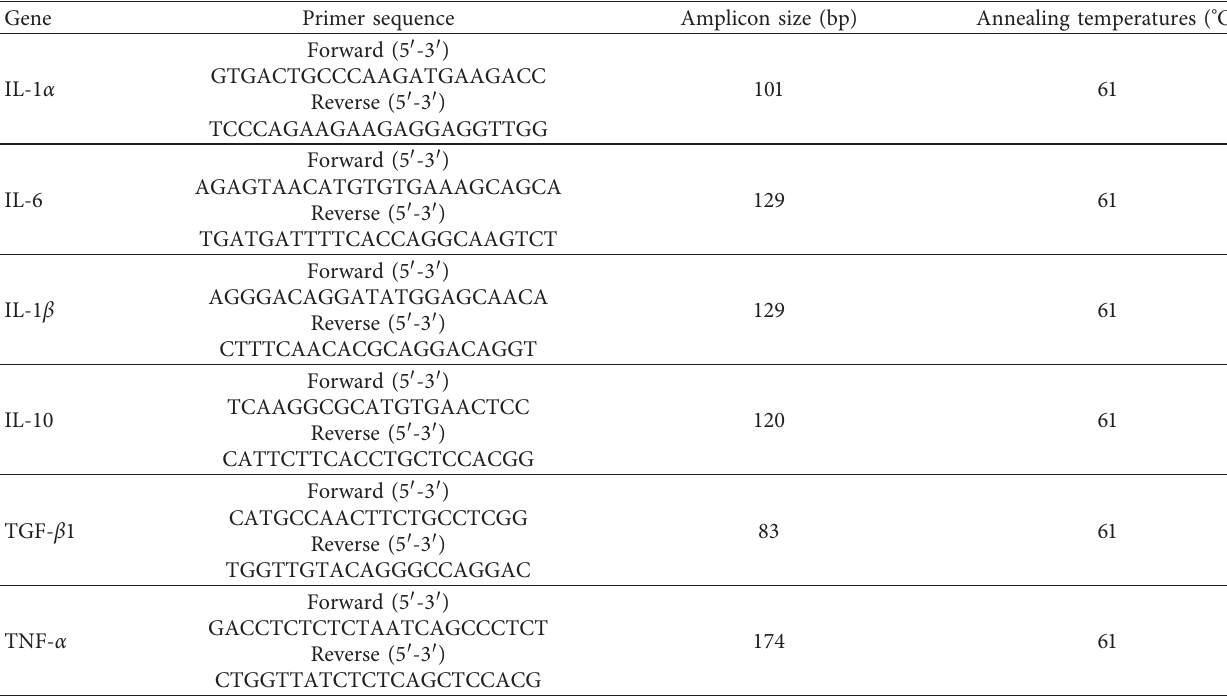
Table 1: Primer sequences and other information used to determine the expressions of pro- and anti-inflammatory cytokines. Gene Primer